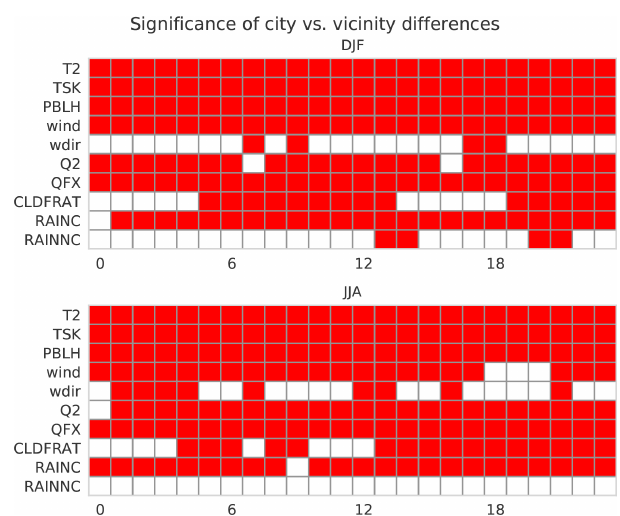
Figure 10. Significance of urban meteorology island components during the day. From above: 2m air temperature ( T 2), surface tem- perature (TSK), boundary-layer height (PBLH), wind speed (wind), wind direction (wdir), specific humidity ( Q 2), upward moisture flux (QFX), cloud cover (CLDFRAT), sub-grid-scale precipitation (RAINC), large-scale (resolved) precipitation (RAINNC). The red colour means statistical significance on the 98%